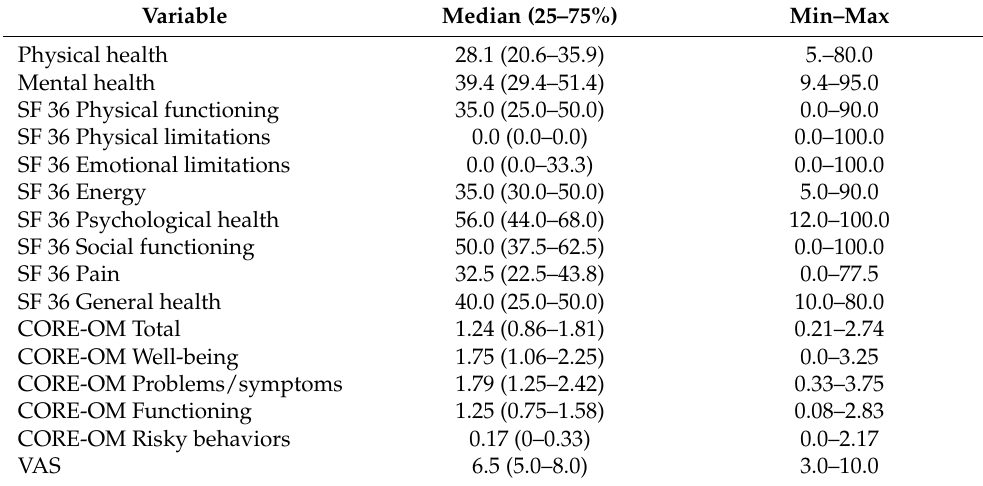
Table 2. Distribution of scores regarding the scales of the SF-36, CORE-OM, and VAS ( n = 148).